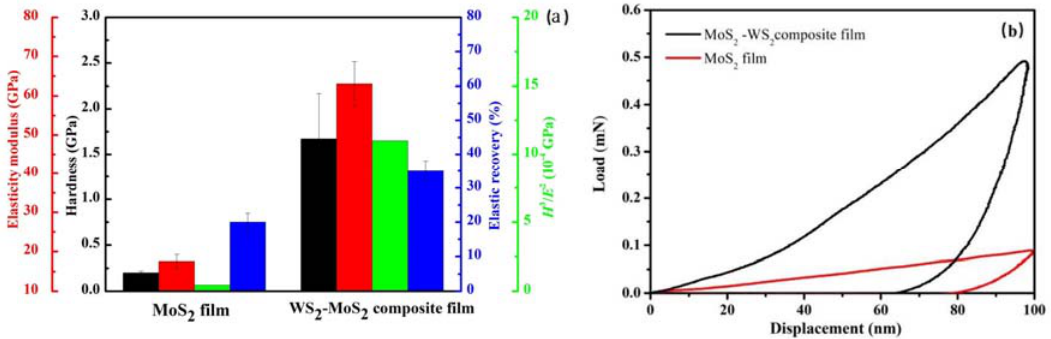
Figure 5. Hardness ( H ), elasticity modulus ( E ), H 3 /E 2 , and elastic recovery for pure MoS 2 film and MoS 2 –WS 2 composite film ( a ) and the typical load ‐ unload curve ( b